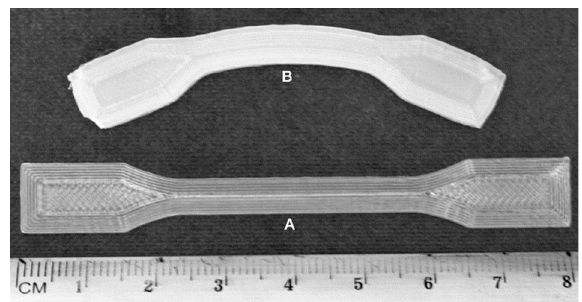
Figure 7. Macrographic image of PLA-60/200 specimen conditioned 2 h at 110 °C before (A) and after (B) placing at 110 °C.